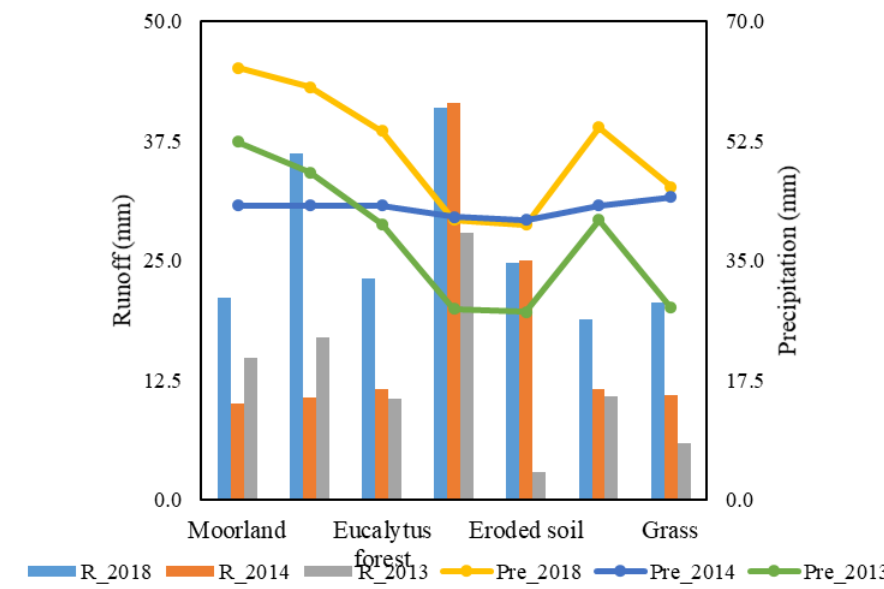
Figure 5. Precipitation-runoff relationship for the year 2014, 2013 and 2018 of the Guano river micro-basin.